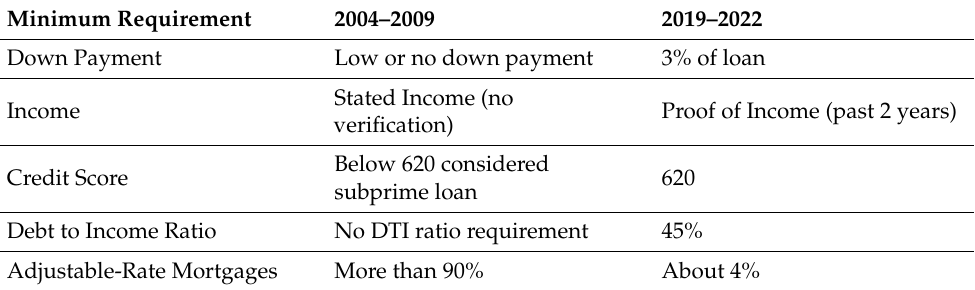
Table 1. Comparison of Mortgage Requirements Between the 2005–2009 and 2019–2022 Periods.